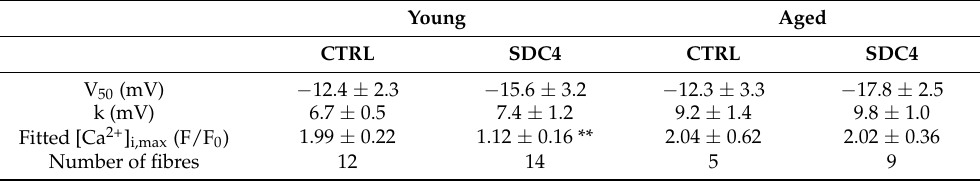
Table 5. Parameters of voltage activation of calcium release in FDB.